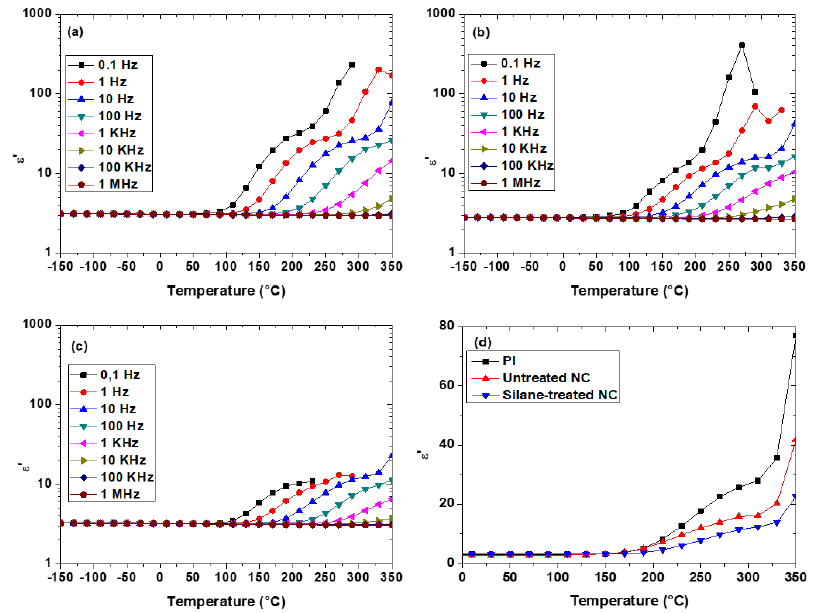
Figure 2. Temperature dependence of the real part of the relative dielectric permittivity for ( a ) neat PI, NC with ( b ) un- treated and ( c ) treated NPs. ( d ) Evolution of the relative dielectric permittivity at 10 Hz as a function of temperature.